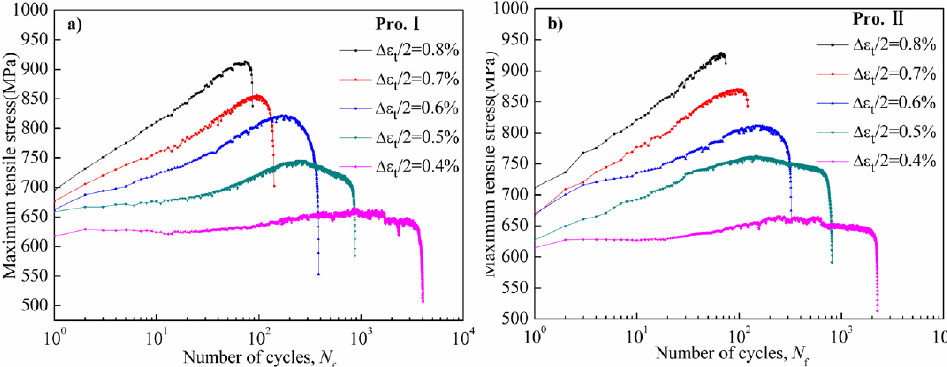
Figure 6. Cyclic stress response curve of the nickel-base alloy at 650 °C. ( a ) Pro.I; ( b )